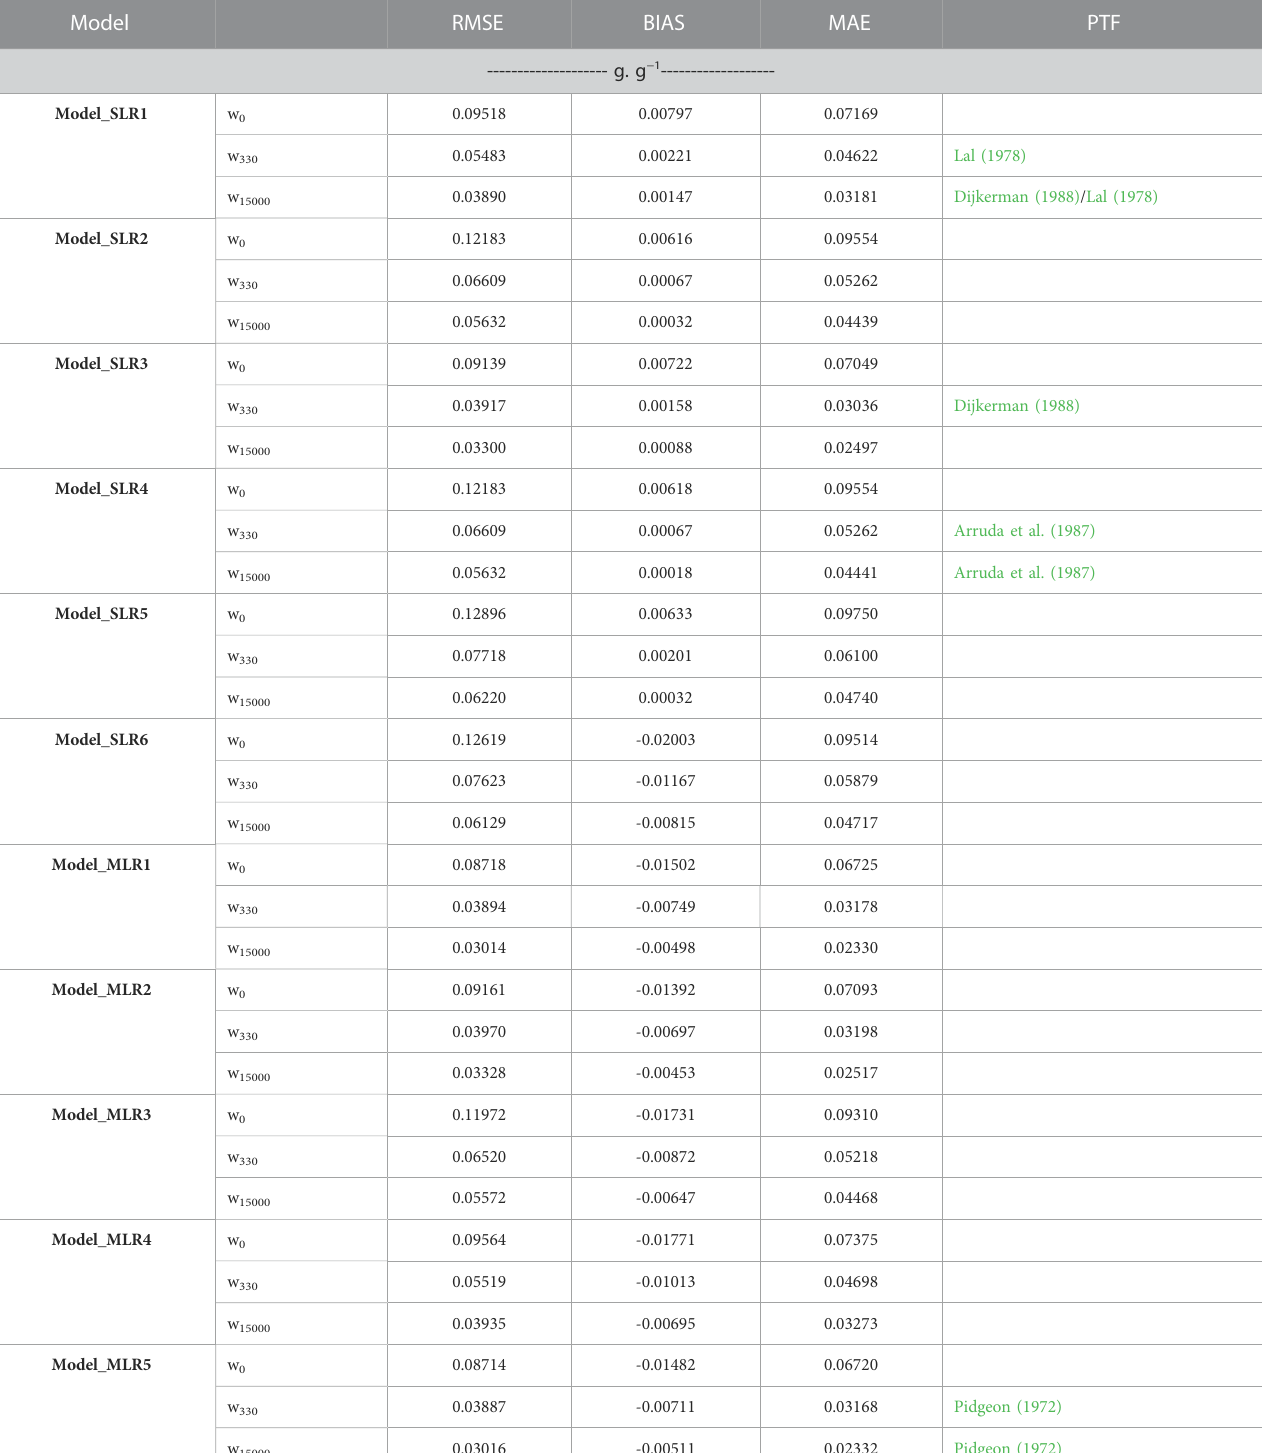
TABLE 8 Evaluation of pedotransfer functions based on simple linear regression (Model_SLR1 to Model_SLR6) and multiple linear regression (Model_MLR1 to Model_ MLR5) using iSDAsoil in four regions in Morocco, assessed by root mean square error (RMSE), BIAS, mean absolute error (MAE).